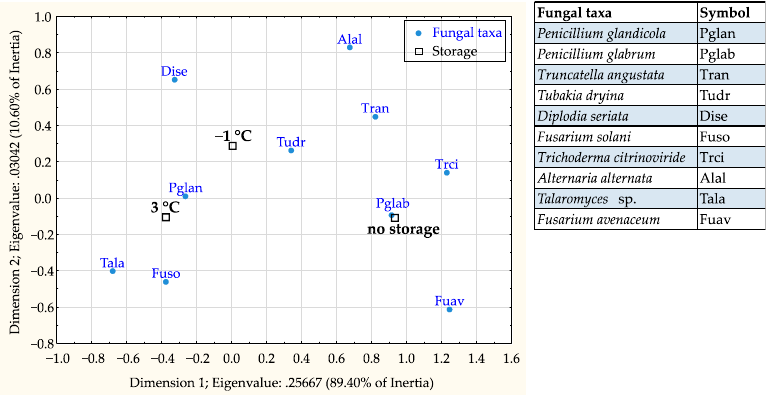
Table 1. Impact of thermotherapy treatment conditions on the number of obtained fungal taxa per acorn tested with multiple comparison of mean ranks for all groups post hoc test (significant p values among treatments are highlighted in red).